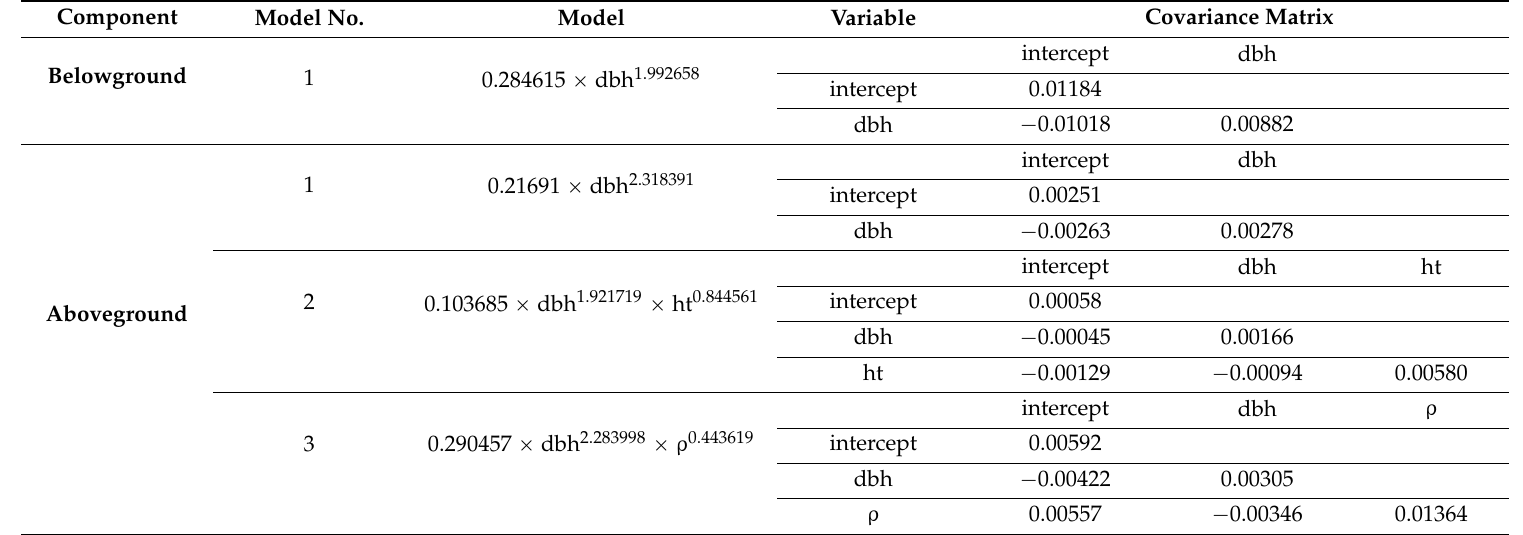
Table A3. Covariance matrices of all valid above- and belowground